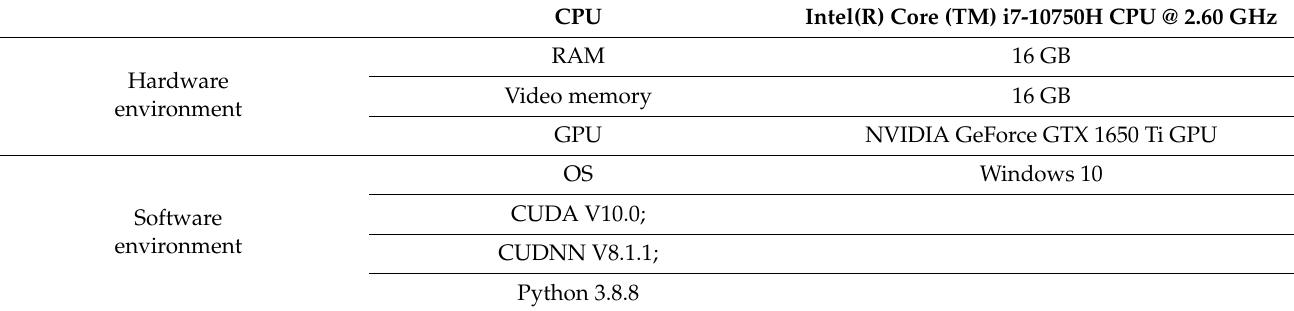
Table 1. Hardware and software parameters.